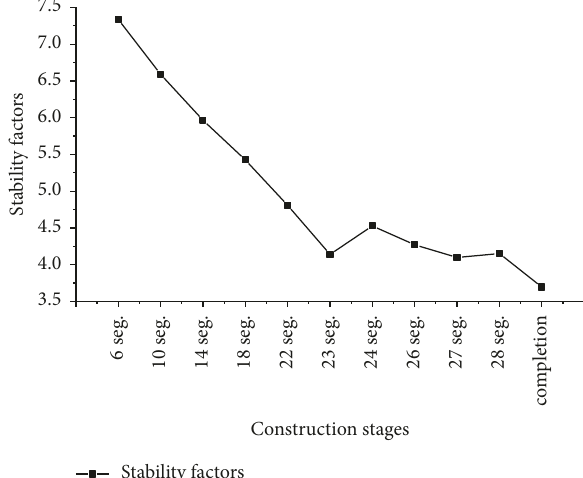
Figure 4: Analysis results of linear stability under different conditions.